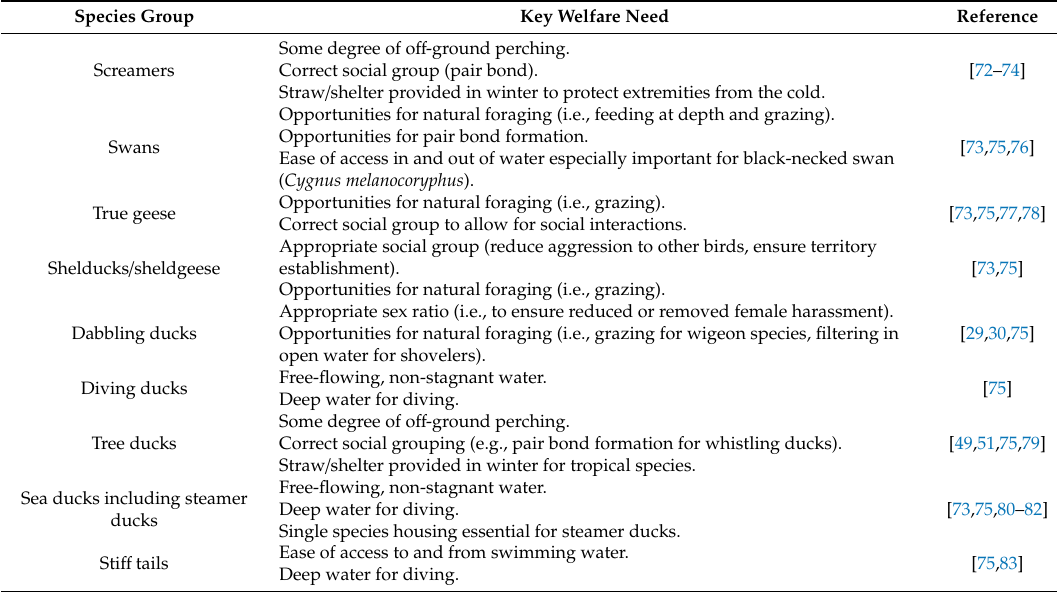
Table 4. Examples of essential enclosures or husbandry requirements for select Anseriformes groups to guide the completion of a welfare